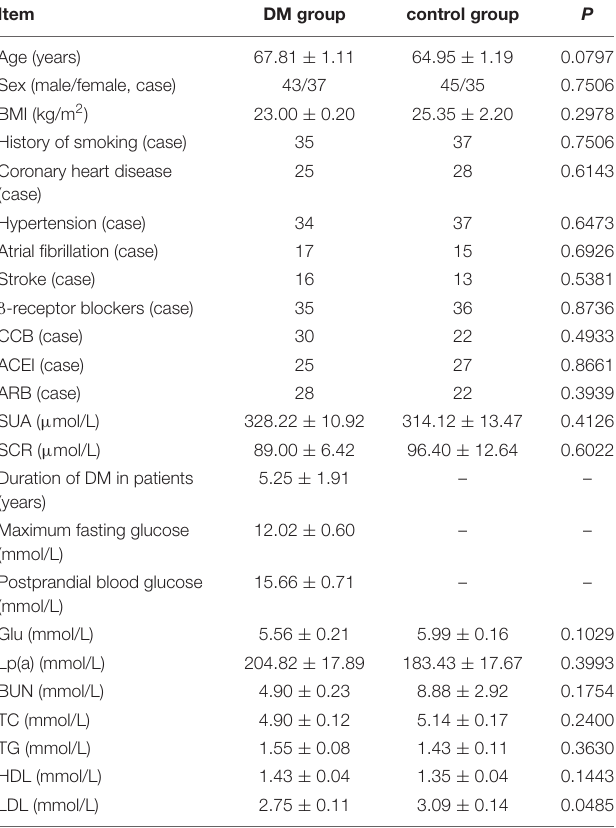
TABLE 2 | The primers for the top five most relevant target genes regulated by miRNA-126 and miRNA-28-3p, respectively. Sequence (5 (cid:48) – > 3 (cid:48)